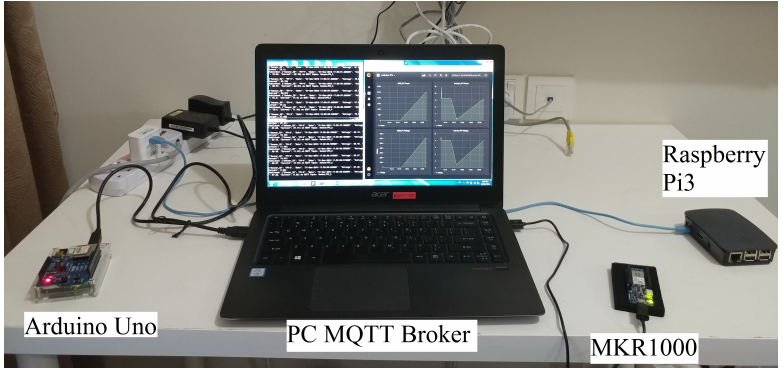
Figure 11. Experiment setup for system heterogeneity experiment.